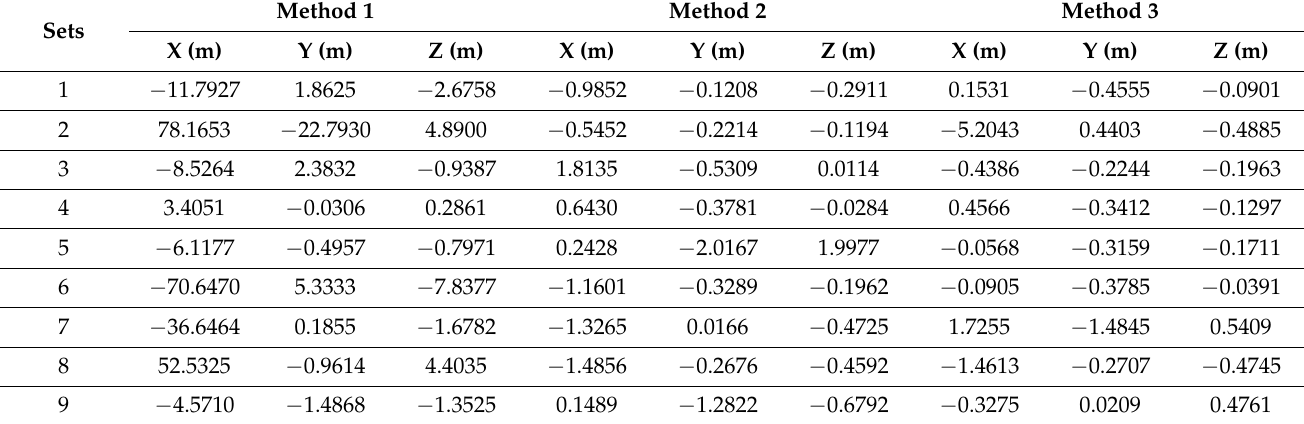
Figure 9. Absolute error of the localization result. Table 3. The absolute error of the localization results of each component.